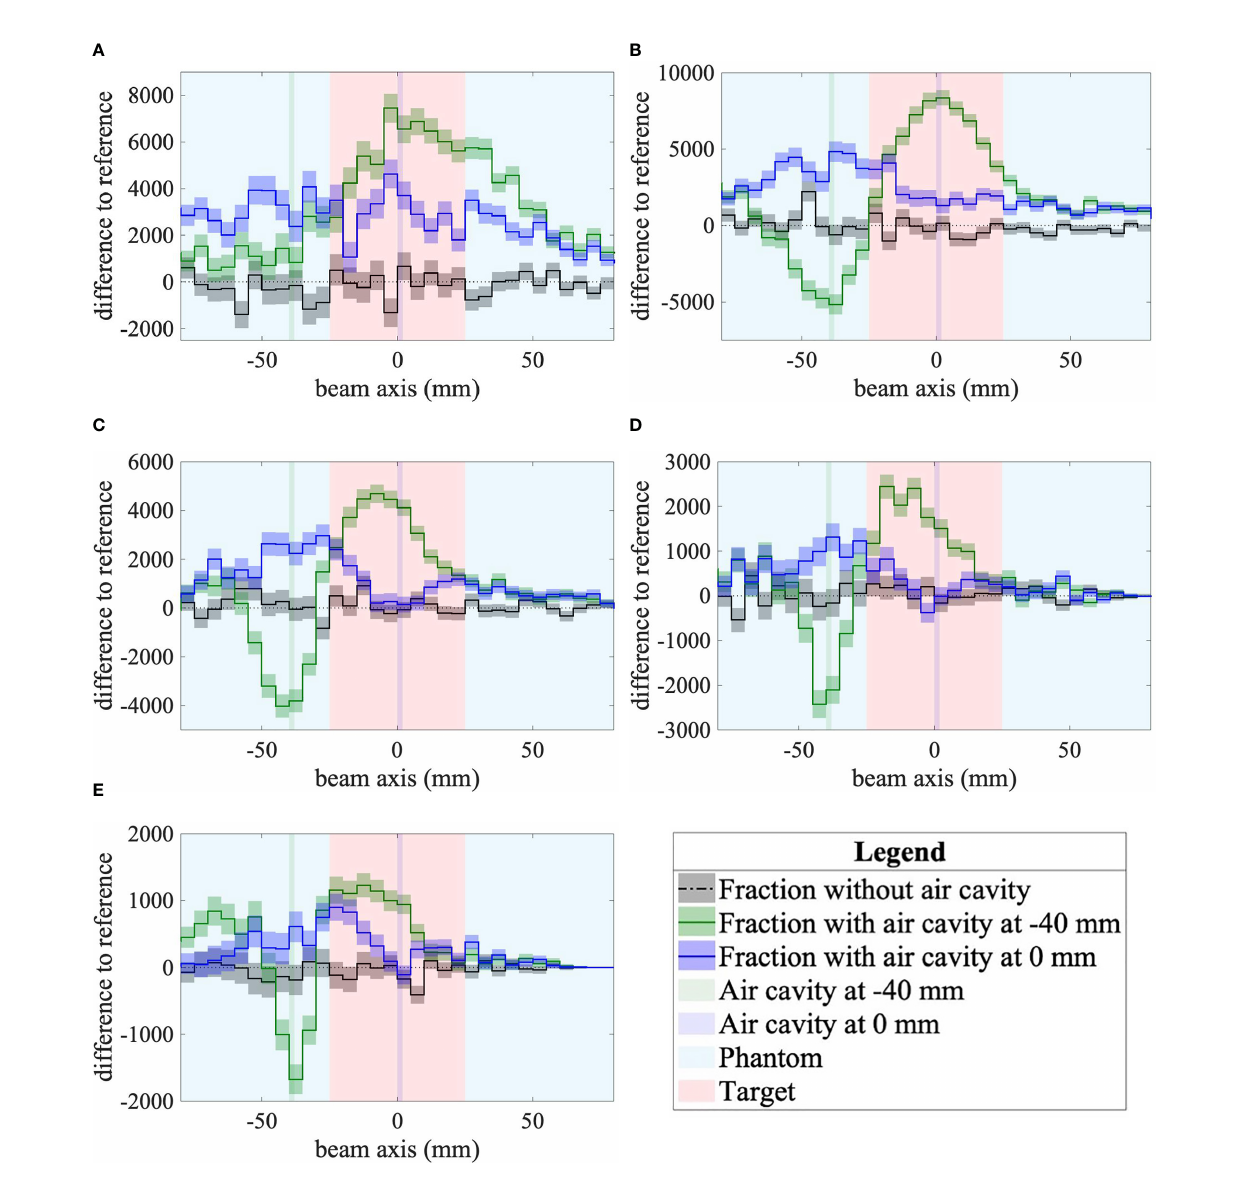
FIGURE 5 | (A) a =10°, d=34 cm. (B) a =20°, d=16 cm. (C) a =30°, d=12 cm. (D) a =40°, d=12 cm. (E) a =50°, d=12 cm. Differences to the reference of secondary- ion emission pro fi les for the three follow-up fractions as measured by the mini-tracker placed at different detection angles and distances to the isocenter. The difference between the reference fraction and the fraction without a cavity is shown as a dotted-dashed black line. The difference between the reference fraction and the fraction with a cavity in front of the tumor volume (depth of -40 mm) is plotted in green. The difference between the reference fraction and the fraction with a cavity in the middle of the tumor volume (0 mm) is plotted in blue. The statistical uncertainties are plotted as uncertainty bands for each curve. The plots show the data inside the 80-mm-radius head phantom, which is centered at 0 mm. The red area represents the 25-mm-radius tumor volume and the inserted air cavity is represented by the vertical green and blue